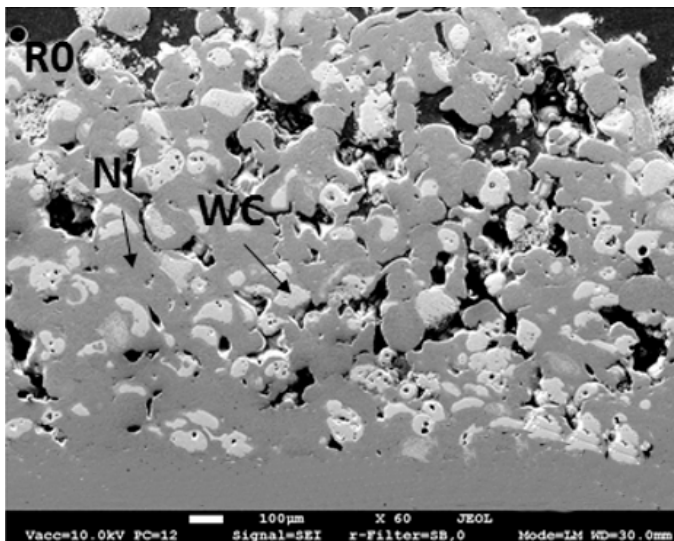
Figure 10. Microstructure of the Ni-7Cr-3Fe + 60% WC coating.